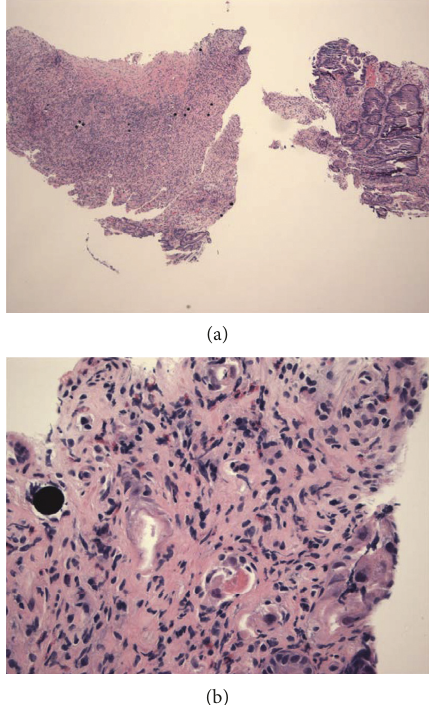
Figure 2: (a) Low-power gastric histology showing multiple black yttrium-90 spheres. (b) High-power histology showing a typical black, gastric yttrium-90